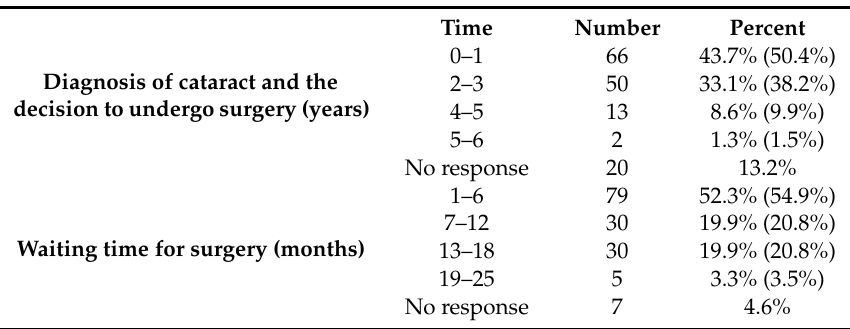
Table 3. Duration of time to make the decision to undergo cataract surgery and waiting for the procedure in the studied group of